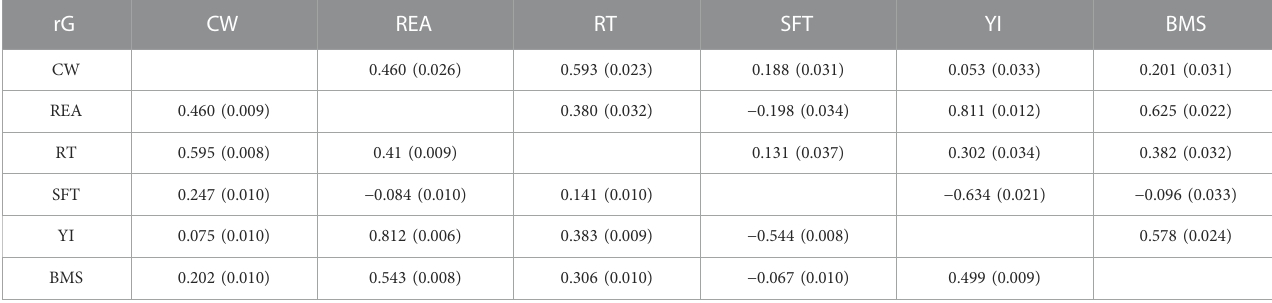
TABLE 3 Phenotypic and genetic correlation between carcass traits of Japanese Black